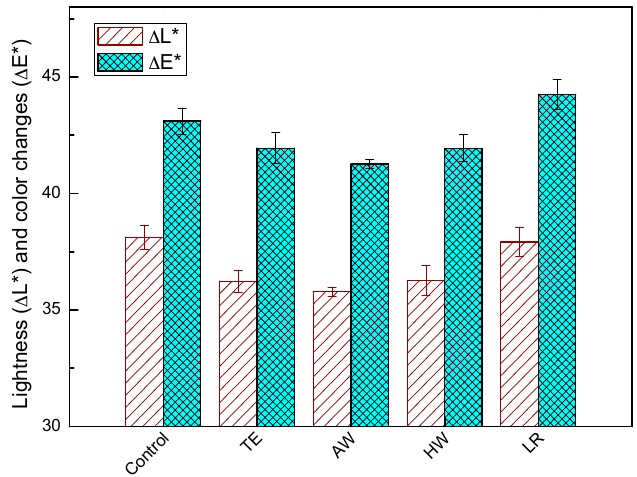
Figure 4. The lightness ( Δ L * ) and total color changes ( Δ E * ) of the WPCs after weathering.